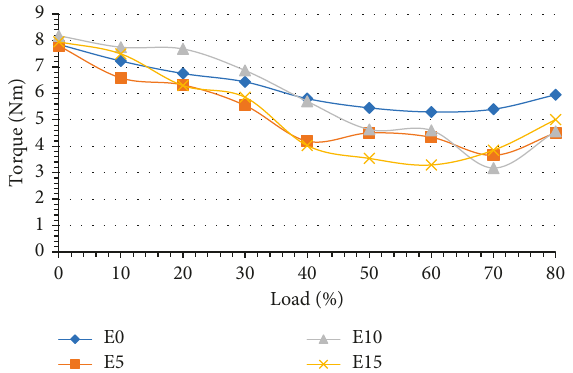
Figure 8: The effect of three elemental nanoparticles in E15 on engine torque output.